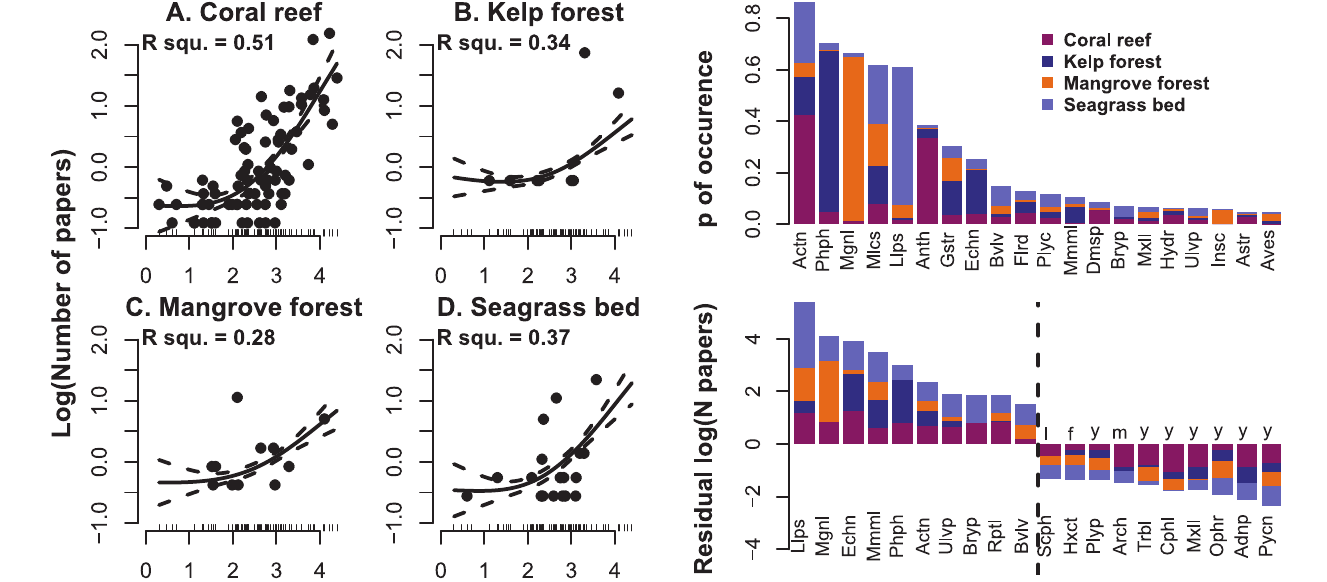
Figure 4. Relative research effort among taxonomic classes. The top 20 ranked classes based on the probability of occurrence in the literature from the four different ecosystems (upper graphs) and the 10 most studied and 10 least-studied classes based on species richness corrected research effort (lower graph)(i.e., deviations from fitted GAMM’s shown in Fig. 3.). Annotations over the 10 least studied classes indicate the likelihood of that taxon being present in any of the four ecosystems: y – known to occur, l – likely to occur, m – might occur, and f – relatively few individuals have been reported to occur therein. Taxonomic class abbreviations are as follows: Actn (Actinopterygii), Adnp (Adenophorea), Anth (Anthozoa), Arch (Arachnida), Astr (Aster- oidea), Aves (Aves), Bryp (Bryopsidophyceae), Bvlv (Bivalvia), Cphl (Cephalopoda), Dmsp (Demospongiae), Echn (Echinoidea), Flrd (Flor- ideophyceae), Gstr (Gastropoda), Hxct (Hexactinellida), Hydr (Hydrozoa), Insc (Insecta), Llps (Liliopsida), Mgnl (Magnoliopsida), Mlcs (Malacos- traca), Mmml (Mammalia), Mxll (Maxillopoda), Ophr (Ophiuroidea), Phph (Phaeophyceae), Plyc (Polychaeta), Plyp (Polyplacophora), Pycn (Pycno- gonida), Rptl (Reptilia), Scph (Scaphopoda), Trbl (Turbellaria), Ulvp (Ulvophyceae).